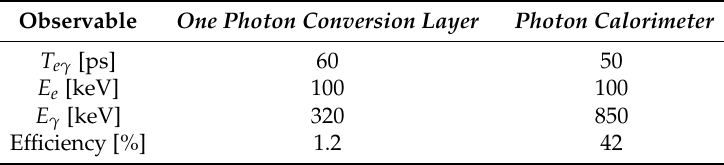
Figure 3. Expected 90% Confidence Level (C.L.) upper limit on the Branching Ratio of µ + → e + γ in different scenarios for a 3-year run. See [14] for details. Table 3. Expected performances (efficiency and resolutions) for a basic design with different options as discussed in the